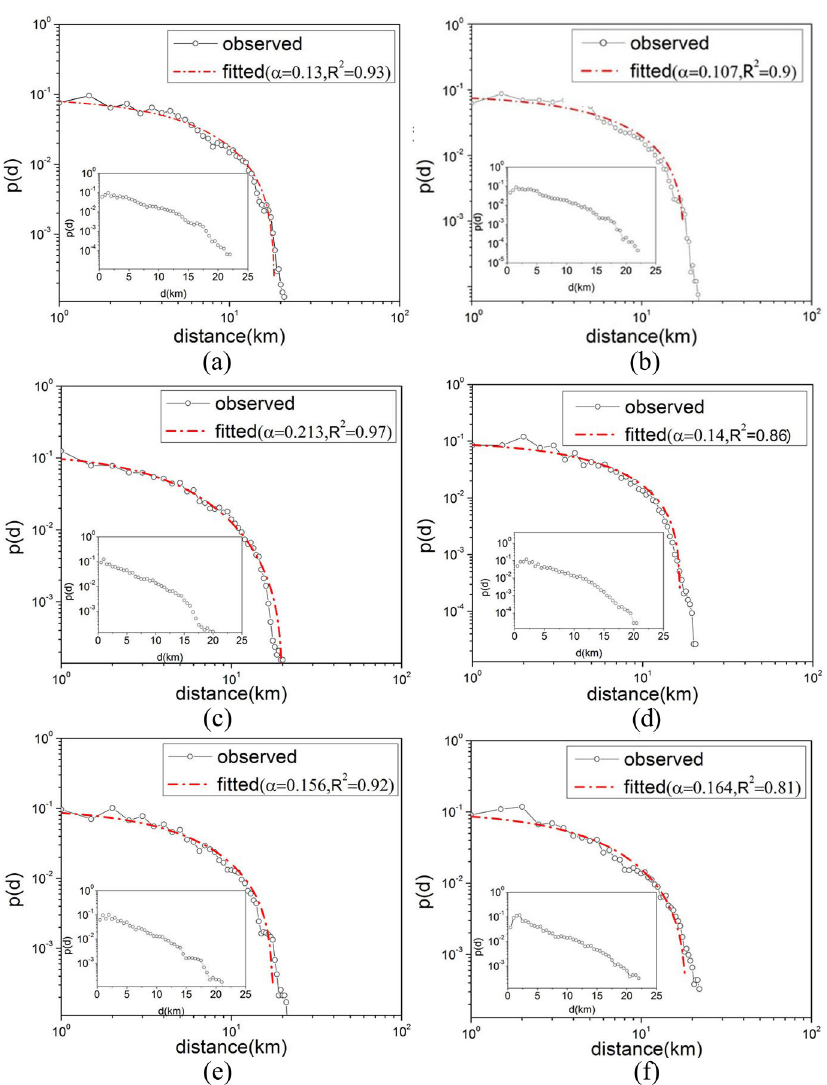
Figure 7. Distance distributions of typical hospitals' visits. ( a ) The First Affiliated Hospital of PLA General Hospital (#304 Hospital); ( b ) Air Force General Hospital; ( c ) Peking University Third Hospital; ( d ) Peking University People’s Hospital; ( e ) Xicheng Woman and Children Health; ( f ) Fengtai Maternal & Child Health Hospital.